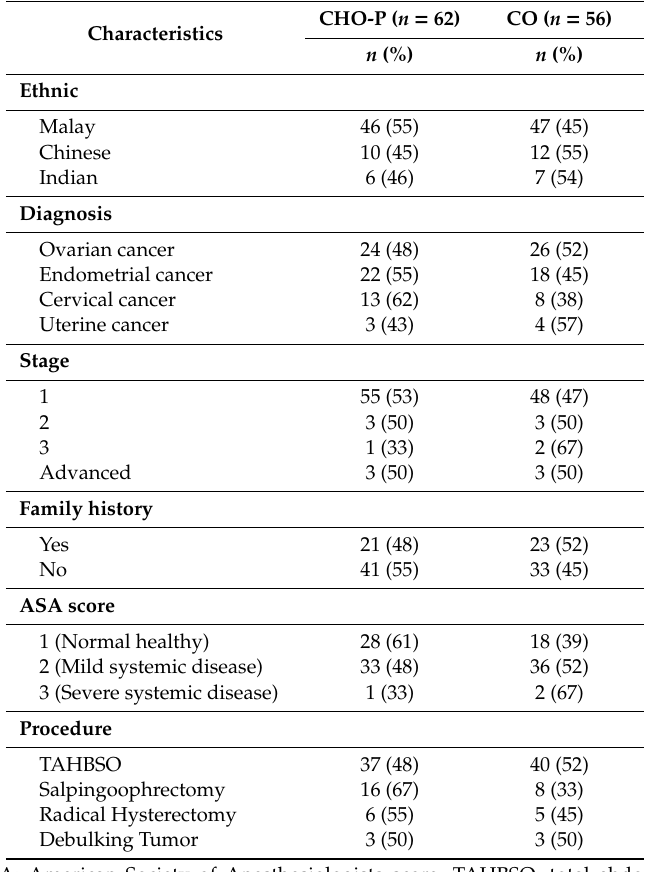
Table 3. Demographic characteristics of intervention group (CHO-P) and control group